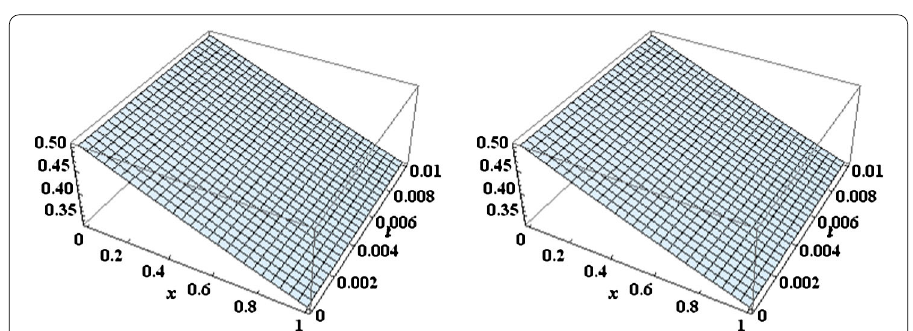
Figure 6 The exact and approximate solutions, respectively, when α =